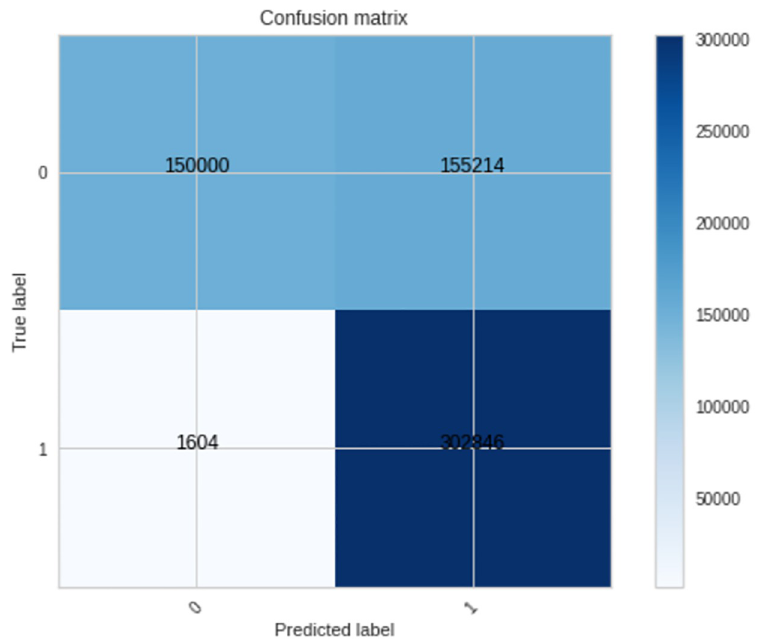
Fig 9. Confusion matrix of the XGBoost model for the APC